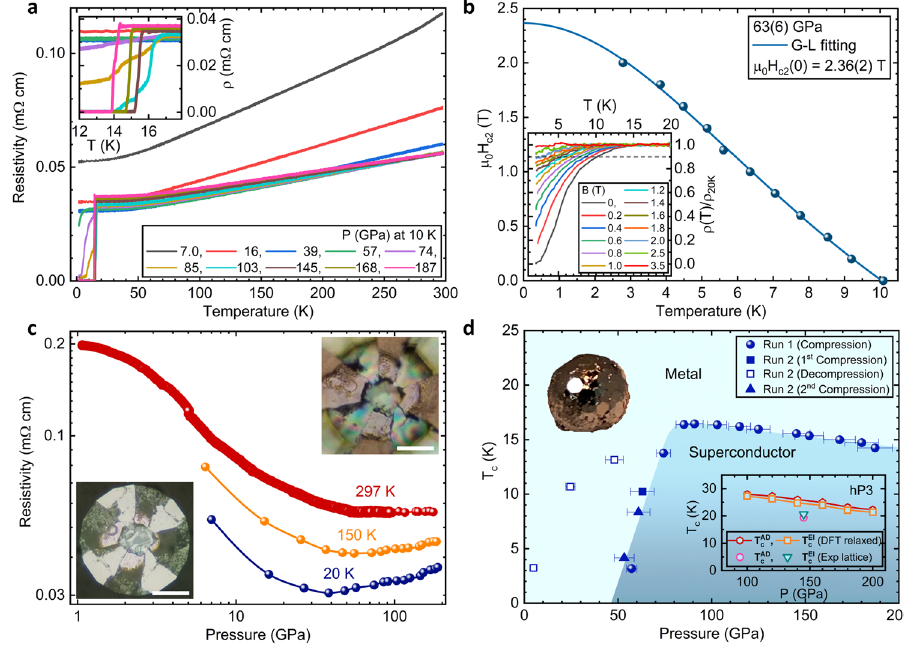
Fig. 1 | Representative high-pressure resistivity curves and T c (P) phase dia- gram. a Temperature-dependent resistivity curves of WB 2 measured while warm- ing at several pressures to 187GPa during compression (7.0 and 16GPa data measured while cooling). The reported pressures are measured at 10K. The black crossedlines represent the criterion used to determine T c (onset).The insetshows an enlarged view of the superconducting transition. b Temperature-dependent upper critical fi eld of WB 2 at 63GPa (Run 2). The dark cyan solid line refers to Ginzburg – Landau (G-L) fi tting. The inset shows temperature-dependent relative resistivity curves (after smoothing) under different magnetic fi elds to 3.5T. The graydashedlineindicates90%ofthenormal-statevalue,wherethe T c isde fi nedfor the upper critical fi eld. c Pressure-dependent resistivity curves at room tempera- ture(RT),150,and20K.Theinsetsshowphotographsoftheexperimentalsetupat ~1 (lower left) and173GPa(upper right),respectively. The white scale bars indicate